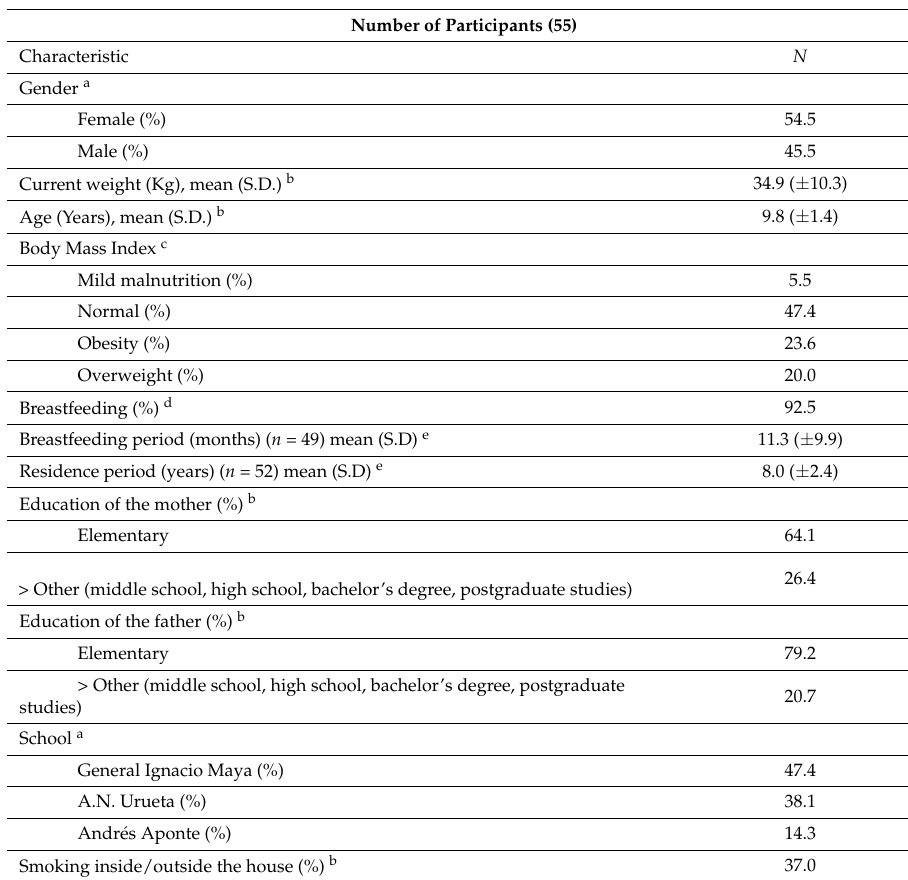
Table 2. Characteristics of the study population in Alpuyeca,